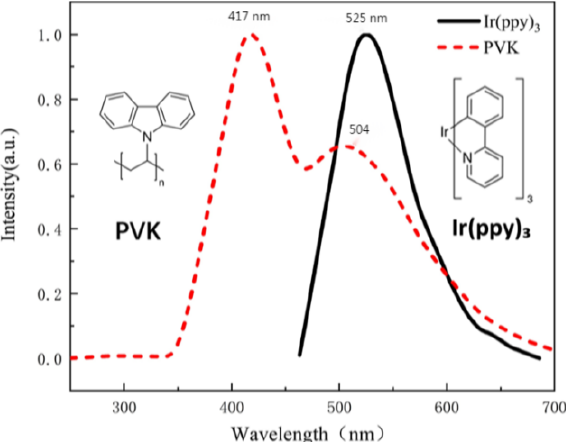
Figure 1. Normalized photoluminescence spectra of PVK and Ir(ppy) 3.